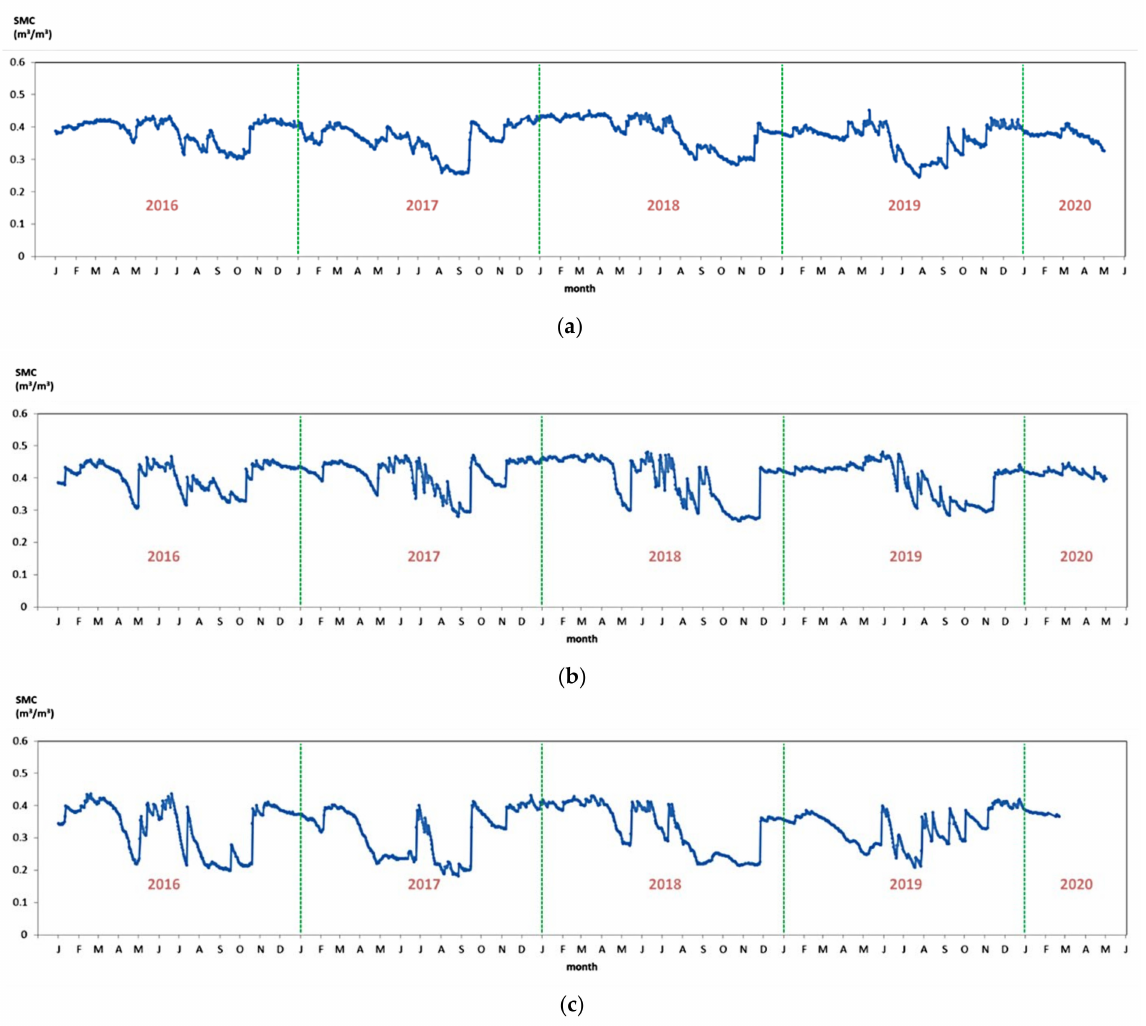
Figure 5. Ground-truth SMC time series of some monitoring sites: ( a ) Site #5 (cropland), ( b ) Site #7 (grassland), ( c ) Site #9